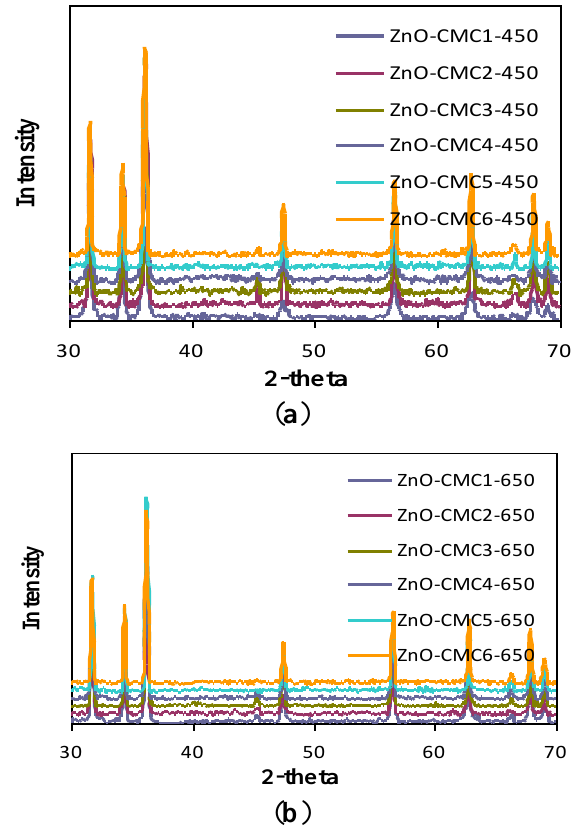
Figure 4. XRD patterns of various ZnO